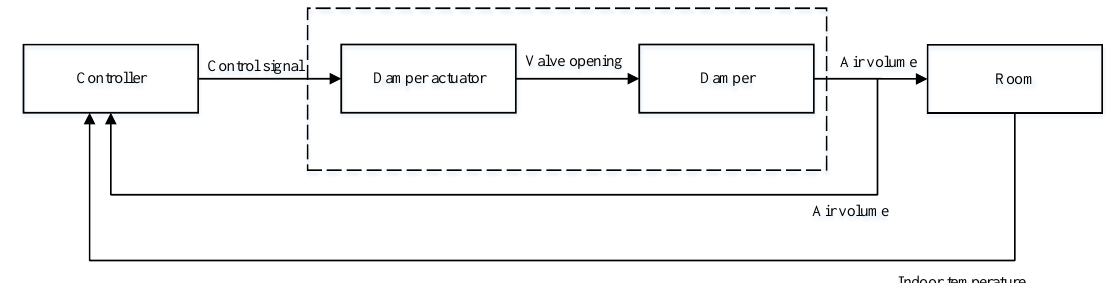
Figure 2. Composition structure of the controlled object.